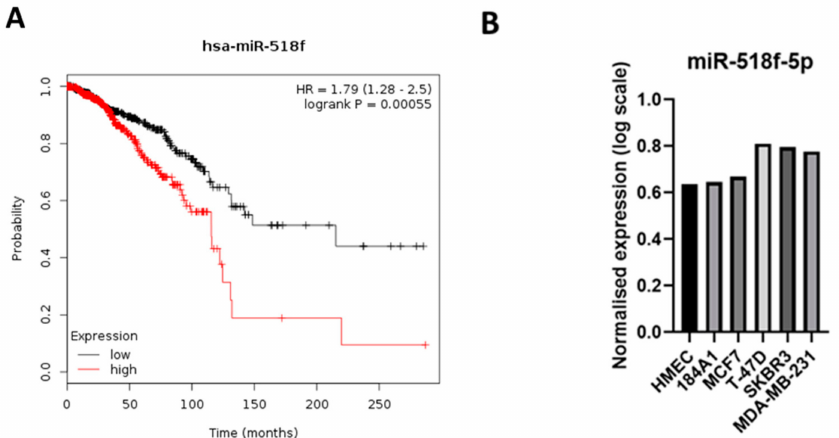
Figure 1. miR-518f-5p expression correlates with poor overall survival in breast cancer and its expression is increased in breast cancer cell lines. ( A ). Kaplan–Meier plot of miR-518f expression compared to the probability of overall survival of breast cancer patients ( n = 1061 from TCGA), generated using miRpower [22]. ( B ). Micro-RNA microarray results which show miR-518f-5p expression across a panel of non-tumorigenic and tumorigenic breast cell lines ( n = 1